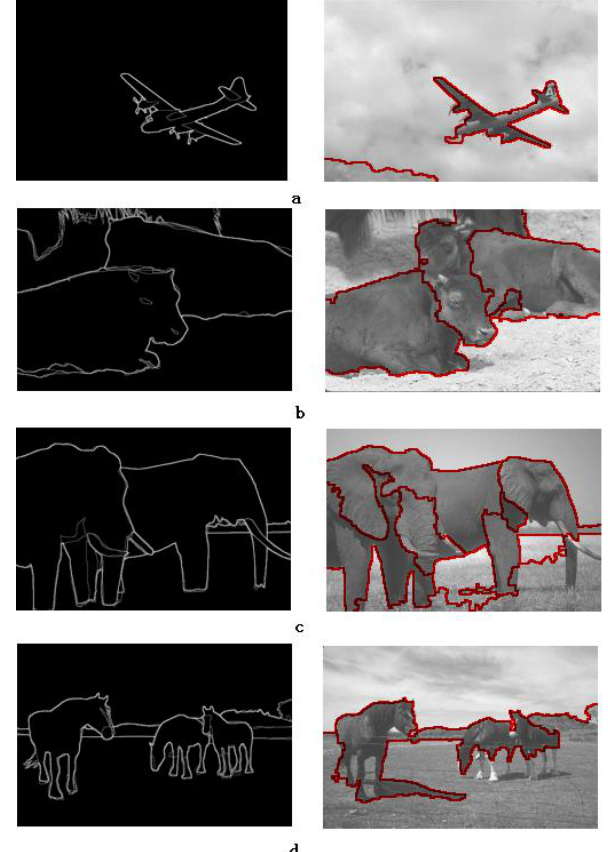
Fig 9. The left column is the human segmentations and the right one is our segmentation results